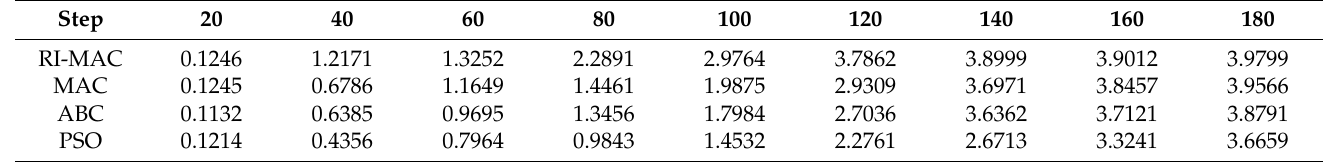
Table 5. Target-discovery benefit of four search algorithms with association rules.